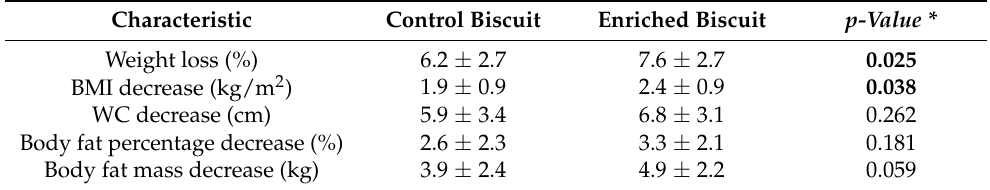
Table 3. 12-week changes in anthropometric characteristics between the subjects of the two